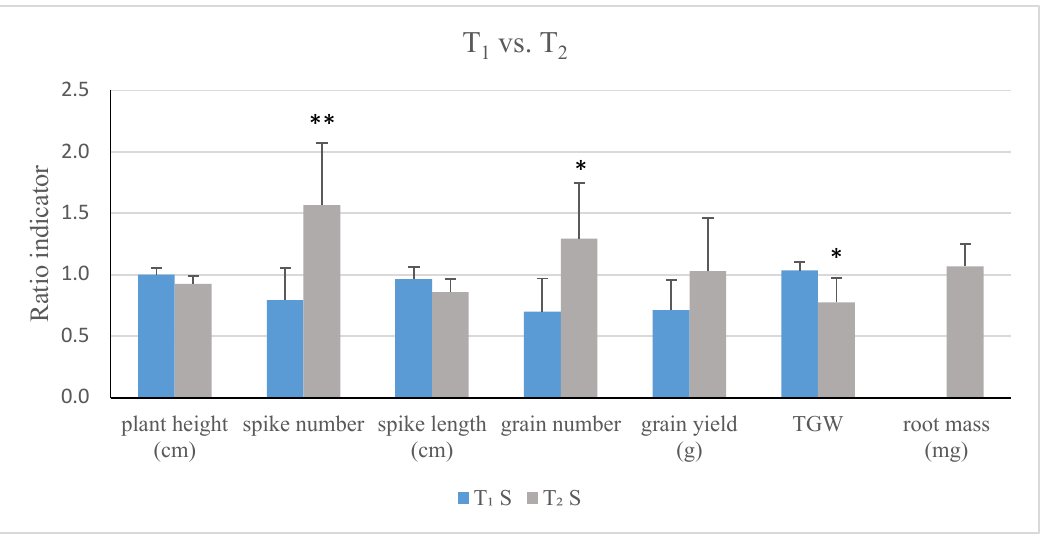
Figure 3. Comparison of phenotypic effect of silencing of TaCKX1 in T 1 and T 2 generations based on ratio indicators. *—significant at p < 0.05; **—significant at p < 0.01.